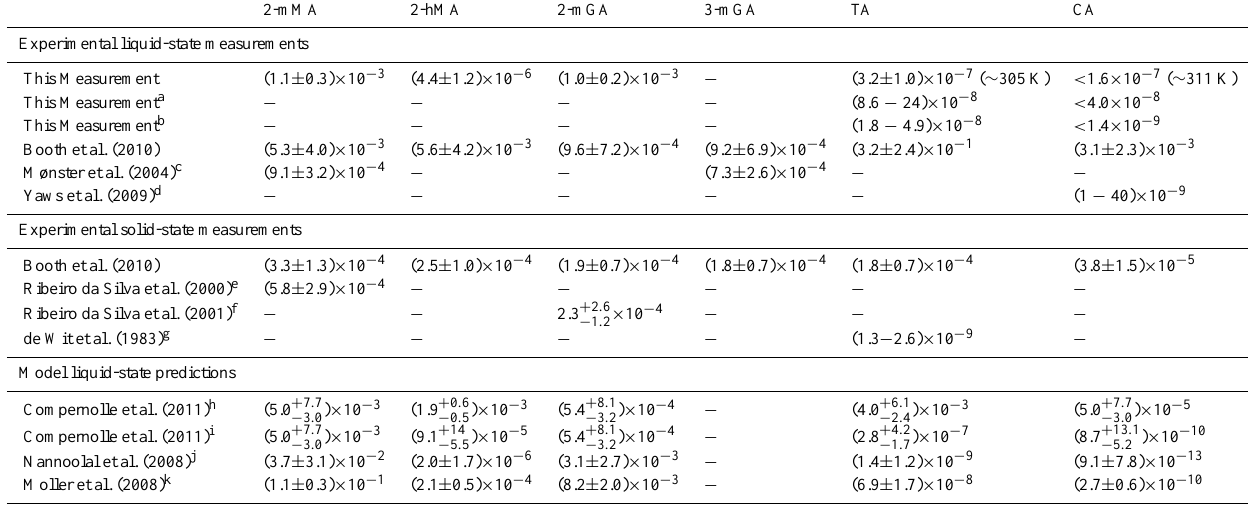
Table 4. Vapor pressure data from this study and comparison to data from the literature. Abbreviations are: 2-mMA, 2-methylmalonic acid; 2-hmA, 2-hydroxymalonic acid; 2-mGA, 2-methylgluratic acid; 3-mGA, 3-methylglutaric acid; TA, DL-tartaric acid; CA, citric acid. Data are organized as experimental studies reporting liquid-state vapor pressure ( p ◦ , L ), experimental studies reporting solid-state vapor pressure ( p ◦ , S ), and model predictions of liquid-state vapor pressure ( p ◦ , L ), including 3-methylglutaric acid for comparison to 2-methylglutaric acid. All data are reported in Pa at T (cid:9) = 298.15K unless stated otherwise. For citric and tartaric acids, extrapolations to T (cid:9) are reported along with data obtained at T > T (cid:9) . Superscript letters indicate notes on data or